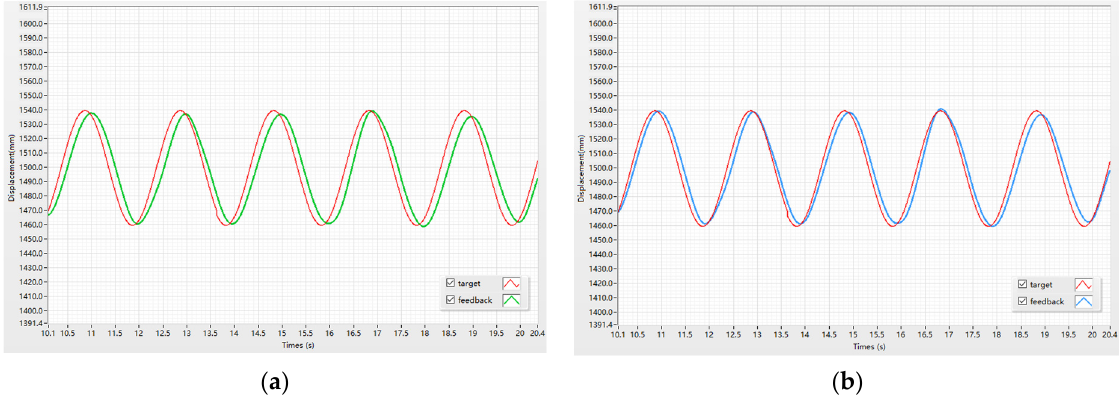
Figure 9. Sine 0.5 Hz following performance test ( a ) Traditional PID control method; ( b ) adaptive inversion control method. Table 3. Displacement following performance parameters of multilevel electromechanical system.